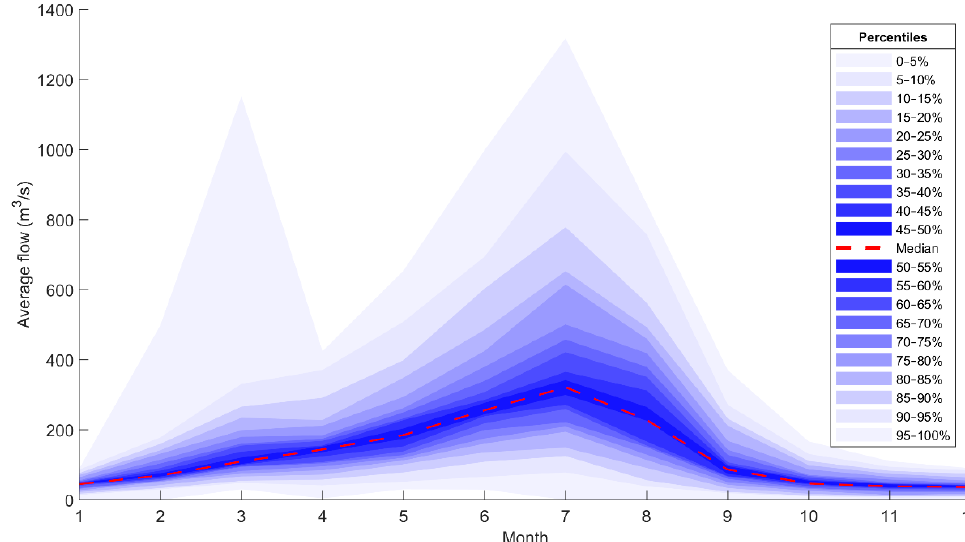
Figure 2. Monthly average discharge variability at the Pay-e-Pol station downstream of Karkheh Dam for local water years between 1954 and 2017 (for months when Karkheh and Seymareh dams existed, data were estimated by observations at closest upstream stations).